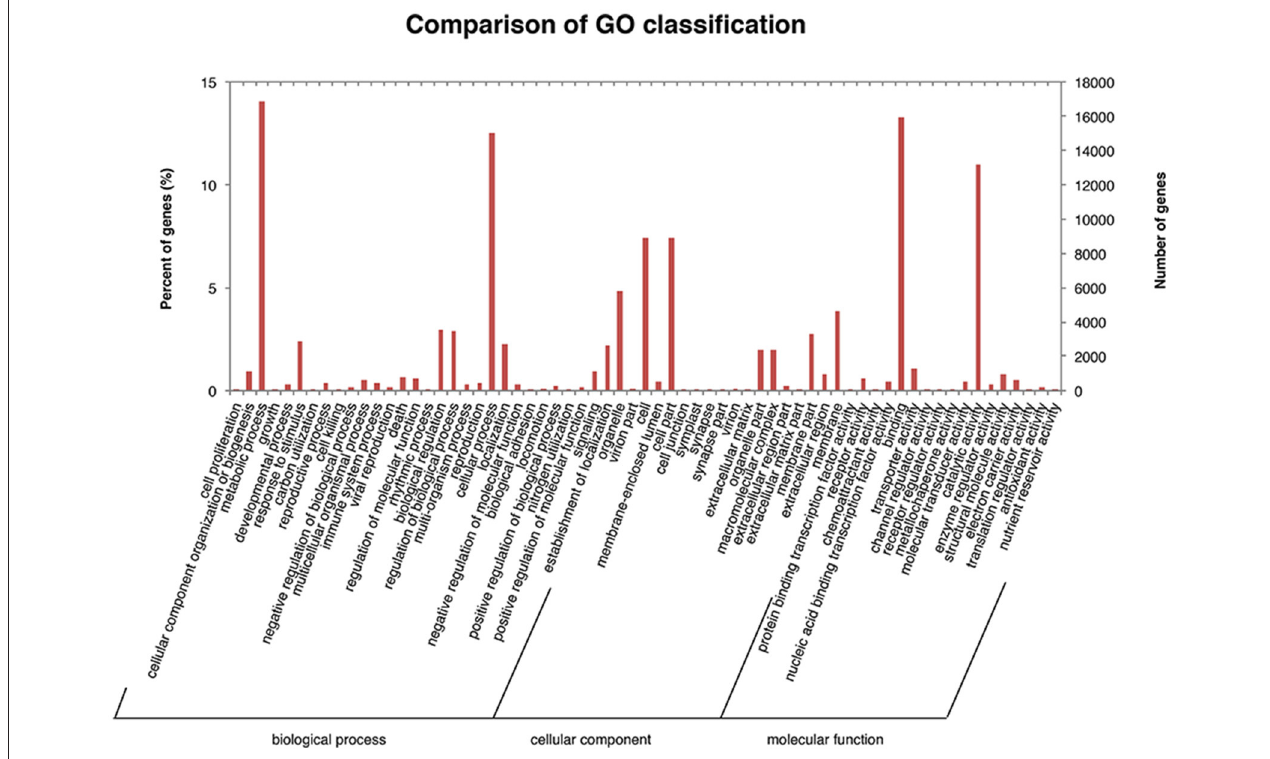
FIGURE 3 | Gene ontology classification of assembled